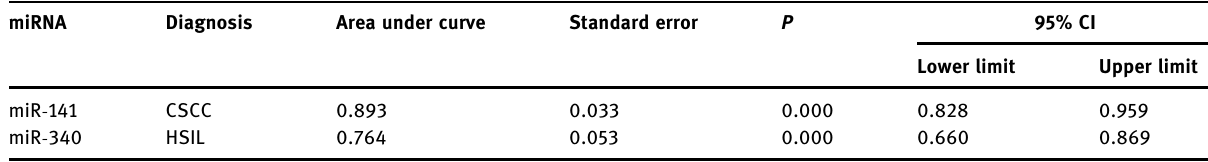
Table 6: The signi fi cance of miR - 141 in CSCC and miR - 340 in HSIL miRNA